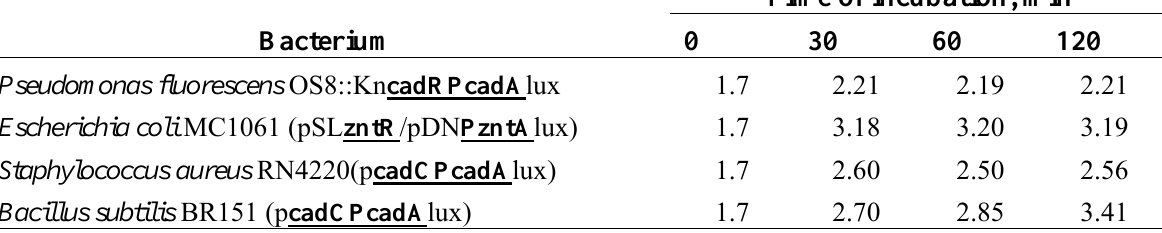
Table 3. Mobilization of Cd from soil-water suspensions by test bacteria after different exposure times. The values show mobilized a Cd in  g·L -1